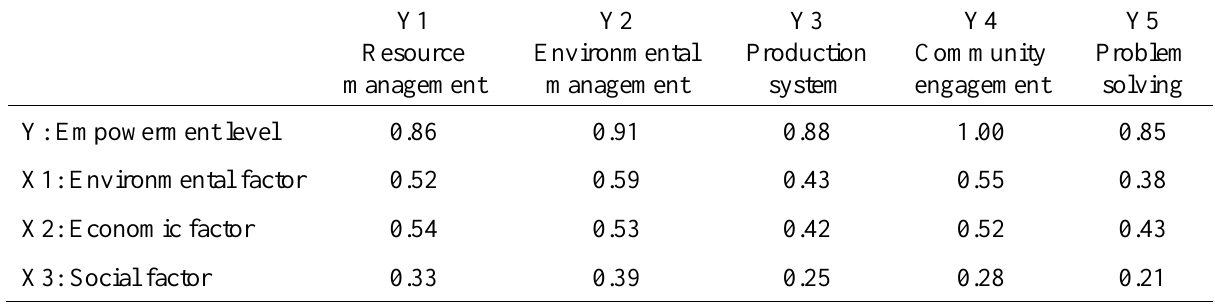
Mires and Peat , Volume 28 (2022), Article 06, 16 pp., http://www.mires-and-peat.net/, ISSN 1819-754X International Mire Conservation Group and International Peatland Society, DOI: 10.19189/MaP.2022.OMB.StA.2376